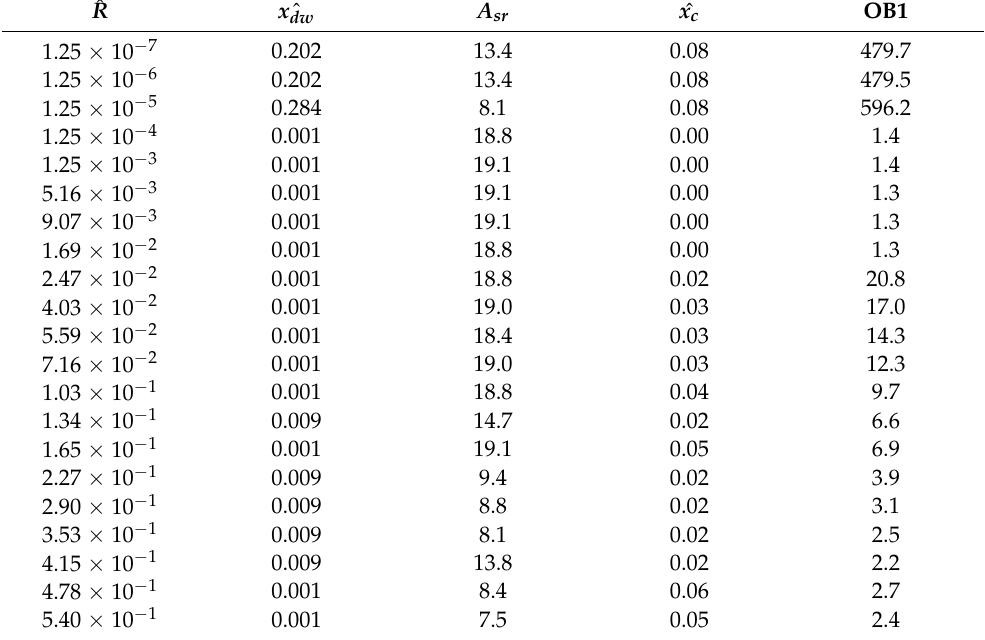
Table 1. Optimized dimensionless parameters for an RPSPV system using an objective function of Equation (34) at the downstream